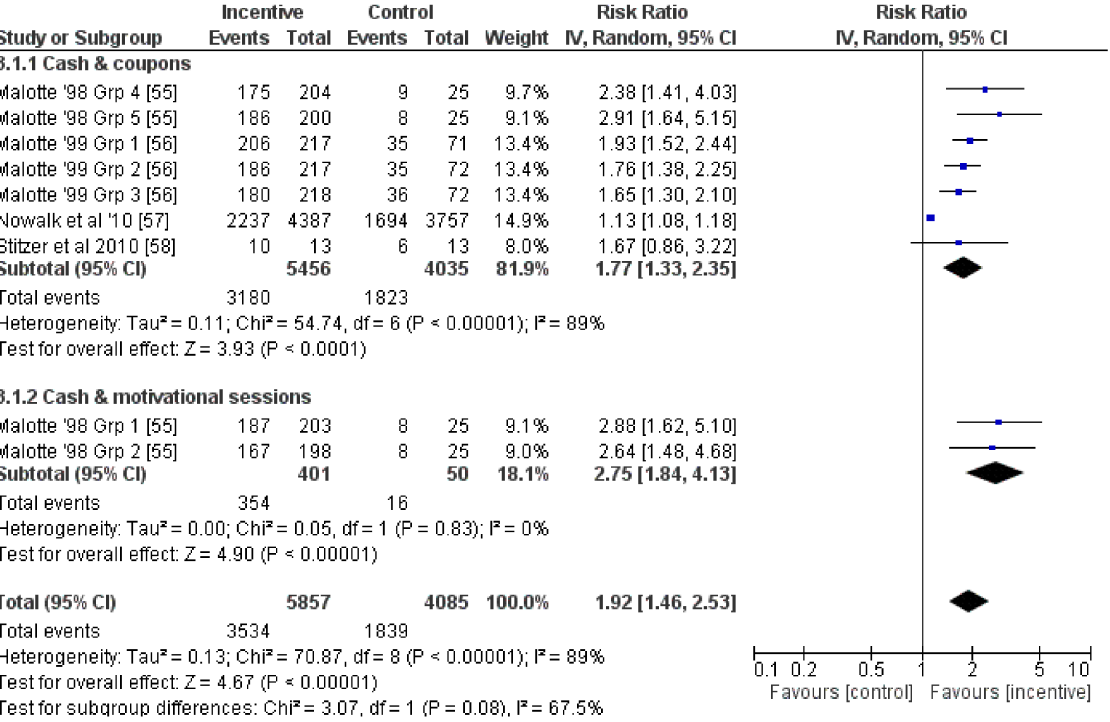
Figure 11. Meta-analysis of financial incentives for attendance at vaccination and screening.